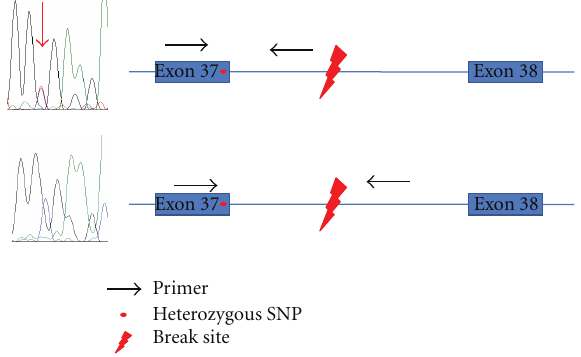
Figure 3: Confirmation of the large FANCI deletion by Sanger sequencing. A part of exon 37 with a SNP was amplified with primers designed either up- or downstream of the deletion break- point. Sequence analyses resulted in the detection of the SNP (red arrow) as heterozygous or hemizygous,